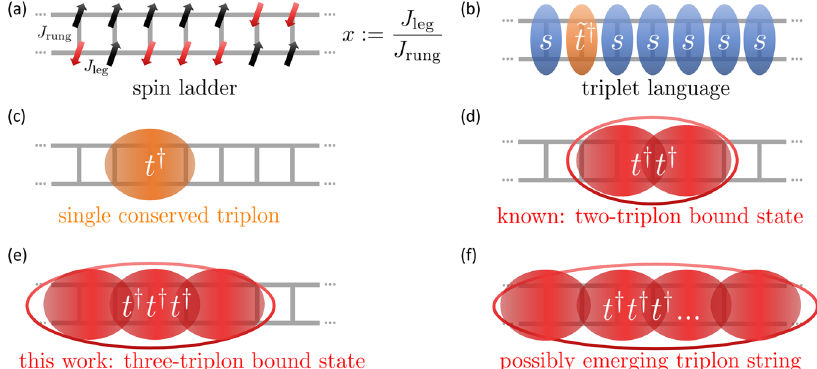
Fig. 1 Multi-triplon states in spin ladders. a The spins S = 1/2 at each vertex of the ladder are coupled by leg ( J leg ), and rung ( J rung ), couplings. The black arrows indicate spin-up and the red arrows indicate spin-down. b For J leg = 0, the spins on each rung form singlets (blue ellipses) in the ground state and local S = 1 triplet excitations (orange ellipsis). c Non-local triplons (wide orange ellipse) are the elementary excitations in spin ladders. They exist in the Δ S = 1 sector and can be detected via inelastic neutron scattering. d Two-triplon interactions lead to the formation of two-triplon bound states (red double ellipse) in the Δ S = 0, 1 sectors. e Three-triplon interactions are strong enough to form three-triplon bound states in the Δ S = 0 sector. f n -strings of triplons can emerge; they are predicted in strongly frustrated spin ladders with additional diagonal couplings (not shown) in each plaquette.